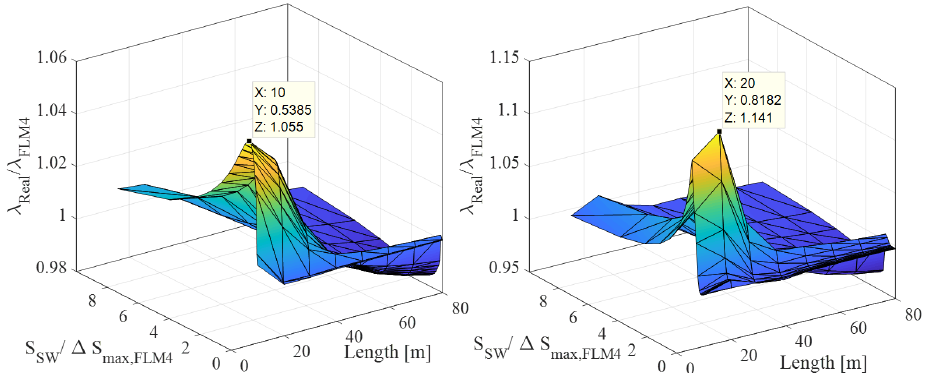
Figure 12. The ratio of λ HFMI for original real traffic in Sweden and λ HFMI for FLM4 (long-distance traffic) calculated for mid-span section (to the left ) and mid-support section (to the right ).